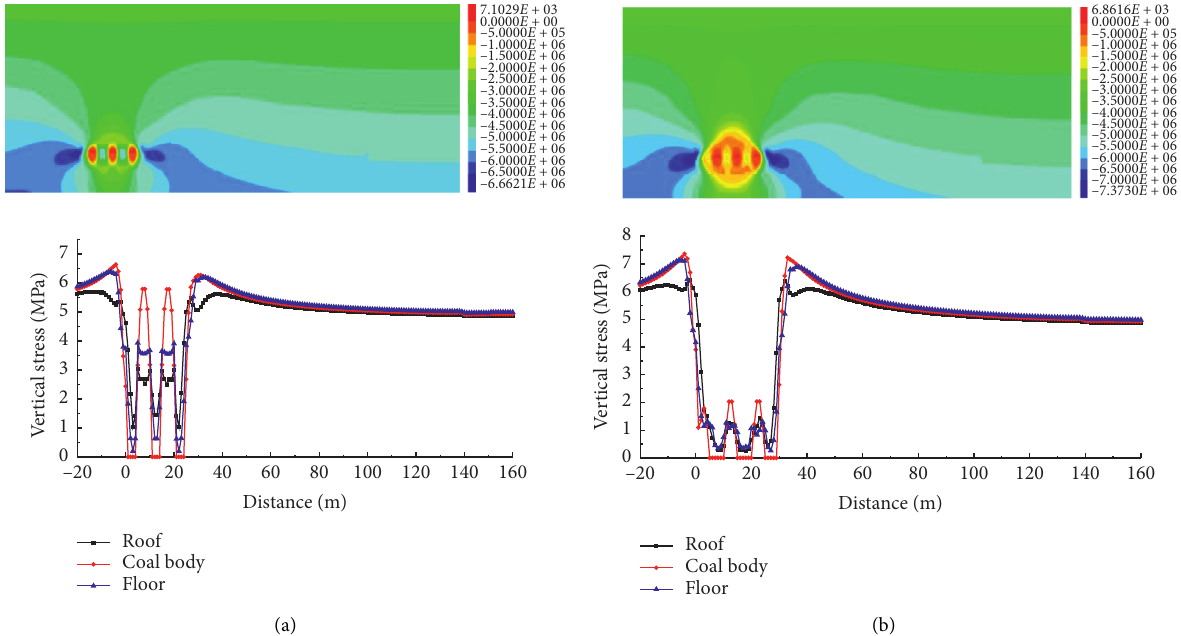
Figure 7: Filling and mining in the first group. (a) One-step mining stress contour and curve. (b) Two-step mining stress contour and curve.